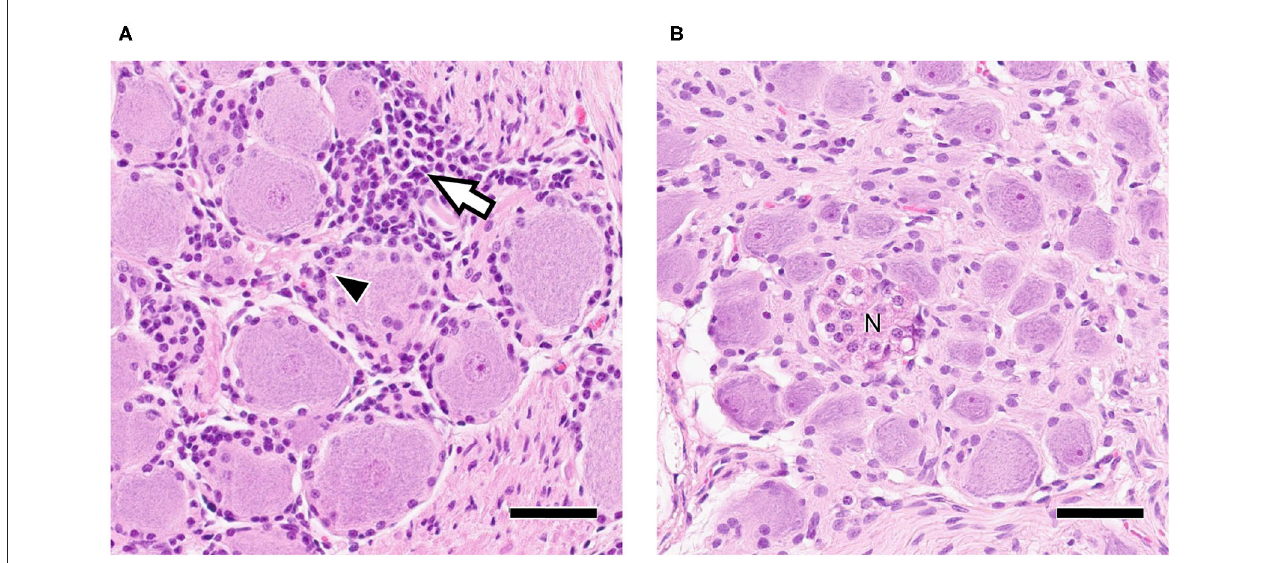
FIGURE 2 | (A) Trigeminal Ganglion 30 dpi: Moderate infiltration of inflammatory cells (white arrow) and satellitosis (arrowhead); (B) Sympathetic trunk ganglion 30 dpi: Nageotte’s body (N) as sign of neuronal degeneration; Bars = 50 µ m.